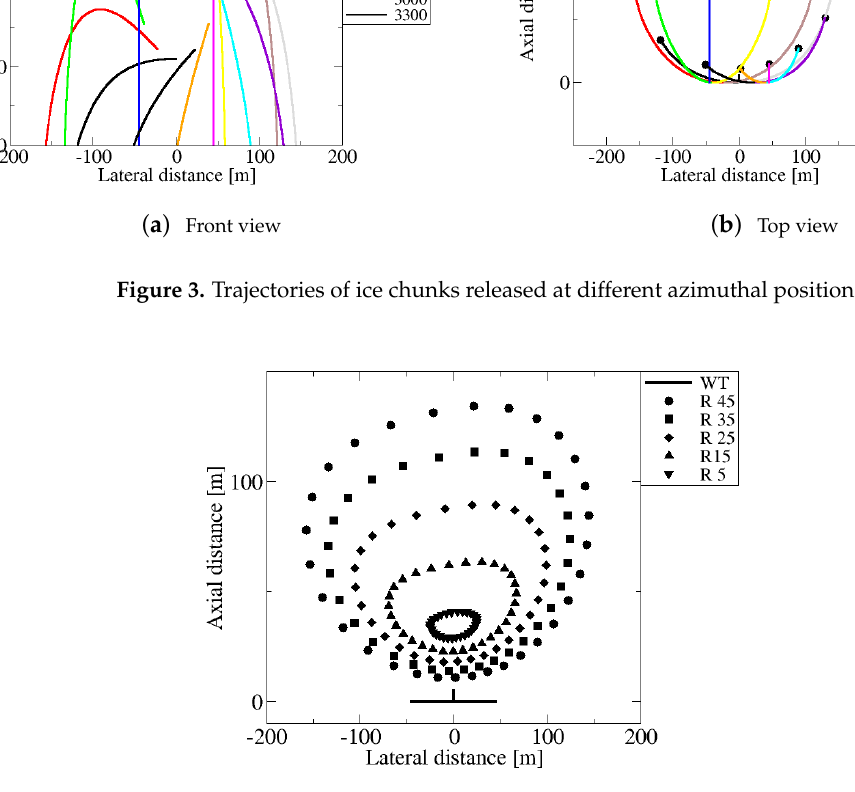
Figure 4. Impact positions for ice chunks released at different radial